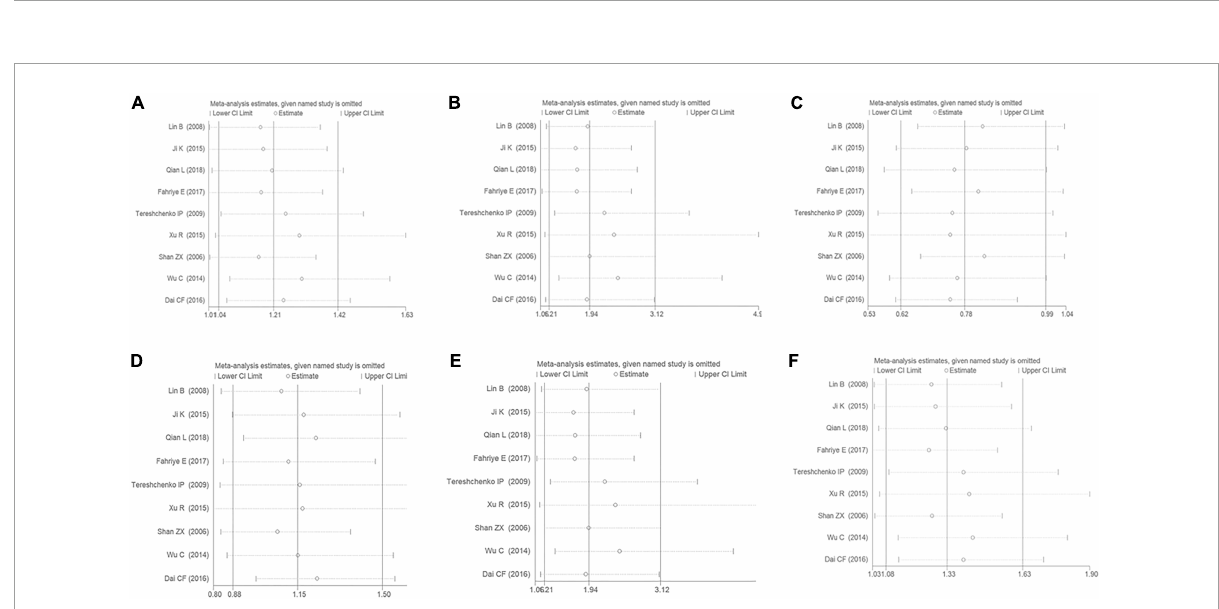
FIGURE8 The sensitivity analysis on the association of CAD and MIF gene rs755622 G/C polymorphism. (A) The sensitivity analysis on the association under an allelic genetic model (i.e., C allele vs. G allele + C allele of MIF gene rs755622 G/C polymorphism). (B) The sensitivity analysis on the association under a recessive genetic model (i.e., CC vs. GG + GC of MIF gene rs755622 G/C polymorphism). (C) The sensitivity analysis on the association under a dominant genetic model (i.e., GG vs. GC + CC of MIF gene rs755622 G/C polymorphism). (D) The sensitivity analysis on the association under a heterozygous genetic model (i.e., GC vs. GG of MIF gene rs755622 G/C polymorphism). (E) The sensitivity analysis on the association under a homozygous genetic model (i.e., CC vs. GG of MIF gene rs755622 G/C polymorphism). (F) The sensitivity analysis on the association under an additive genetic model (i.e., C allele vs. G allele of MIF gene rs755622 G/C polymorphism).